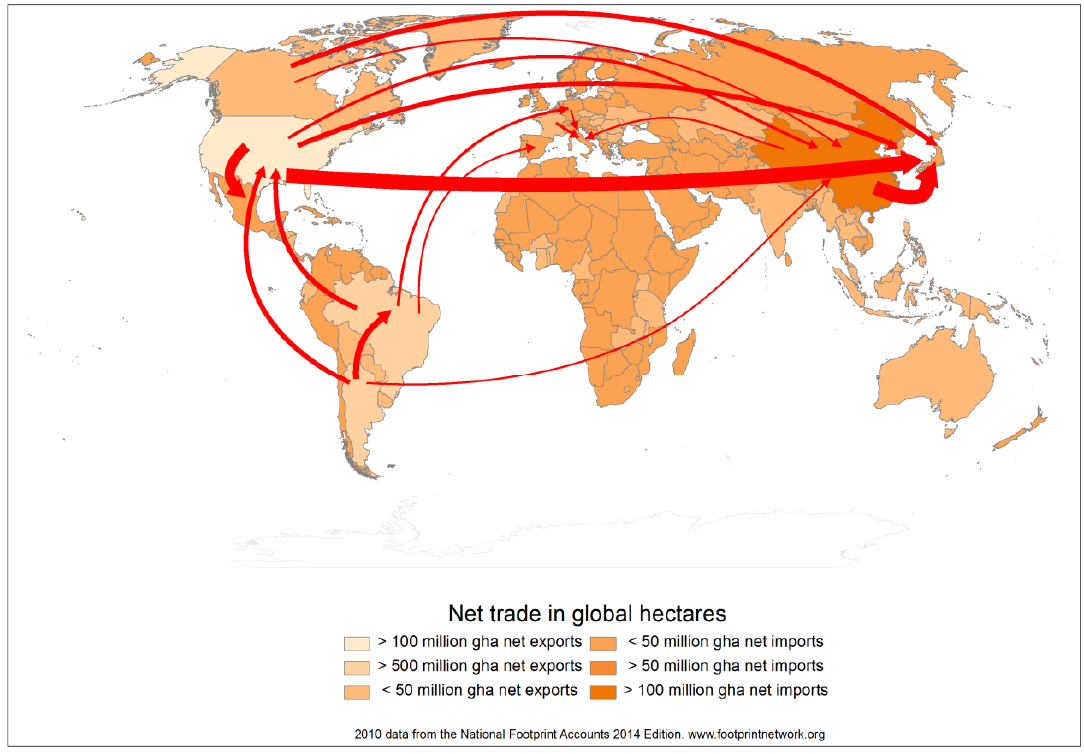
Figure 4. Net trade in cropland biocapacity: arrows sized by magnitude of embodied biocapacity show the flows into the highest three net importers and out of the highest three net